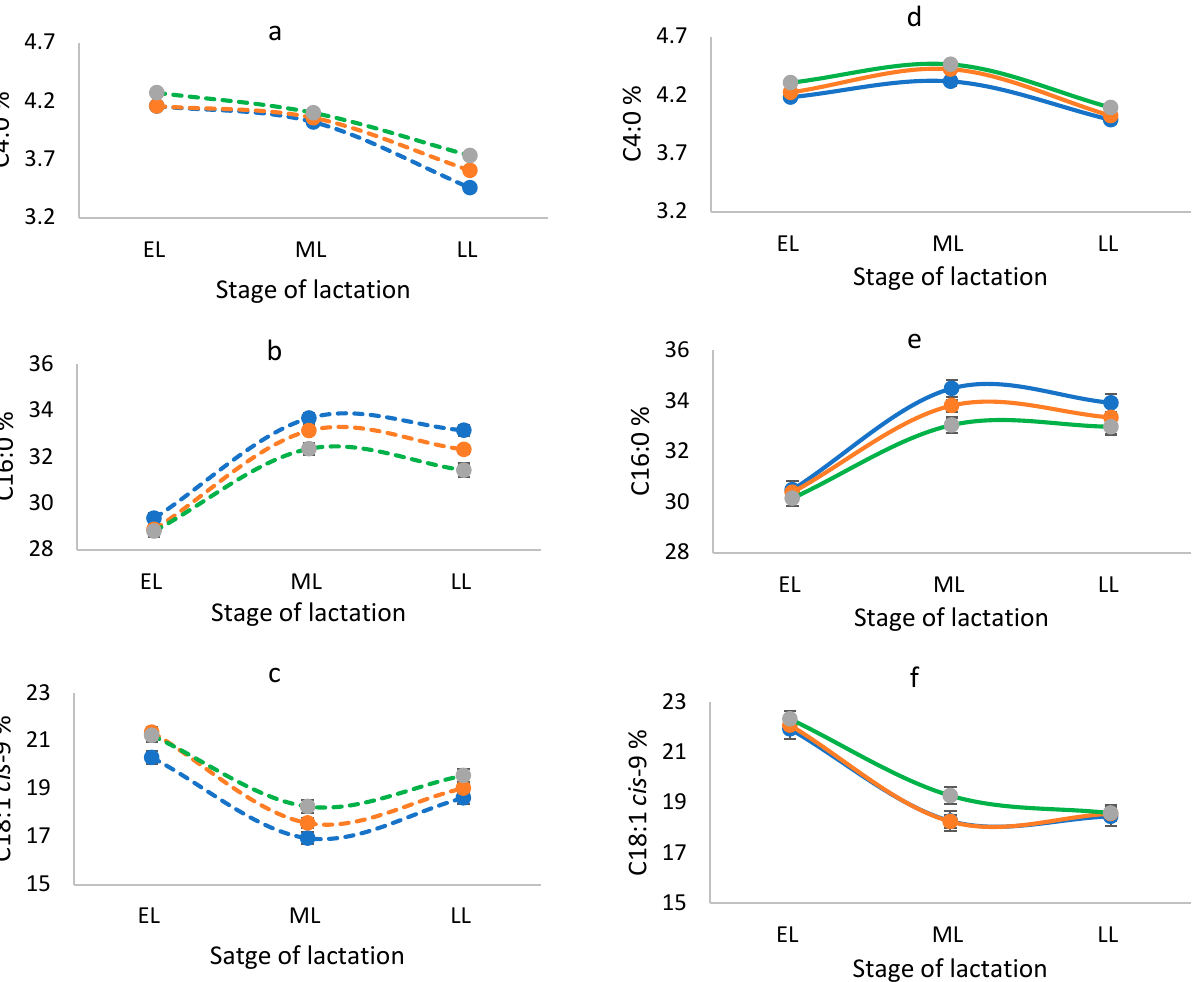
Figure 2. Proportions of ( a ) C4:0, ( b ) C16:0, and ( c ) C18:1 cis -9 for genotypes CC (….), CT ( …. ), and TT ( …. ) in cows milked once a day, and proportions of ( d ) C4:0, ( e ) C16:0, and ( f ) C18:1 cis -9 for genotypes CC ( — ), CT ( — ) and TT ( — ) in cows milked twice a day during the production season 2020–2021. EL = early lactation (<90 days); ML = mid lactation (90–180 days); LL = late lactation (>180 days). The vertical bars show standard errors.